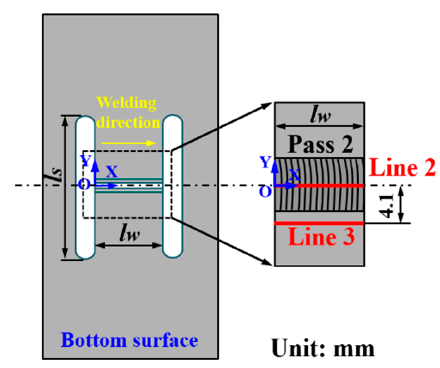
Figure 13. Locations of line 2 and line 3.